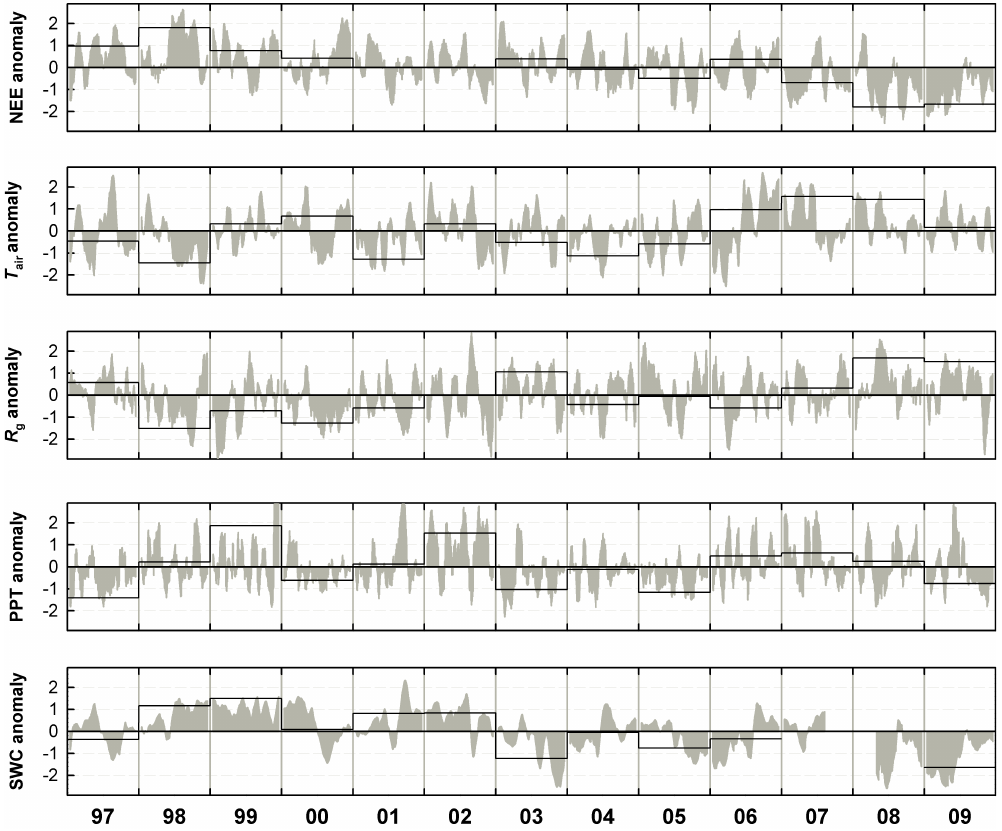
Fig. 1. Deviation of NEE, air temperature ( T air ), global radiation ( R g ), precipitation (PPT) and soil water content (SWC) from the 13yr annual average (black solid line) and daily average values (grey areas). The daily data were smoothed with a 30-day moving average. The y-axis gives the standard deviation from the mean (e.g. the annual NEE anomaly in 1998 is about 2 SD above the 13yr average with less uptake of